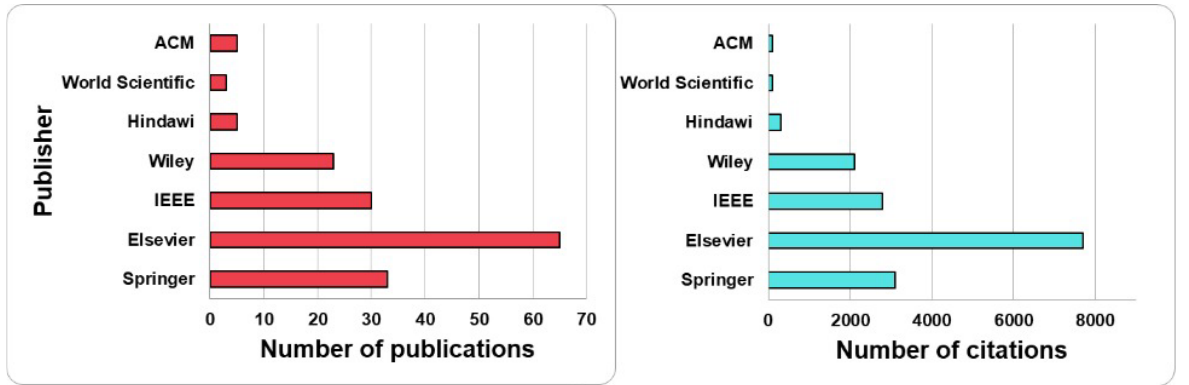
Figure 10. Number of publications and citations for each nature-inspired algorithm in the main publishers regarding research of gene expression data research.